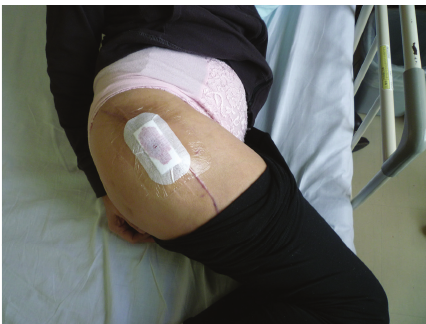
Figure 5: At postoperative day 115, we completely removed the hematoma via approximately a 2 cm surgical skin incision. We removed about 1,000 grams of uncoagulated lightly colored bloody liquid.